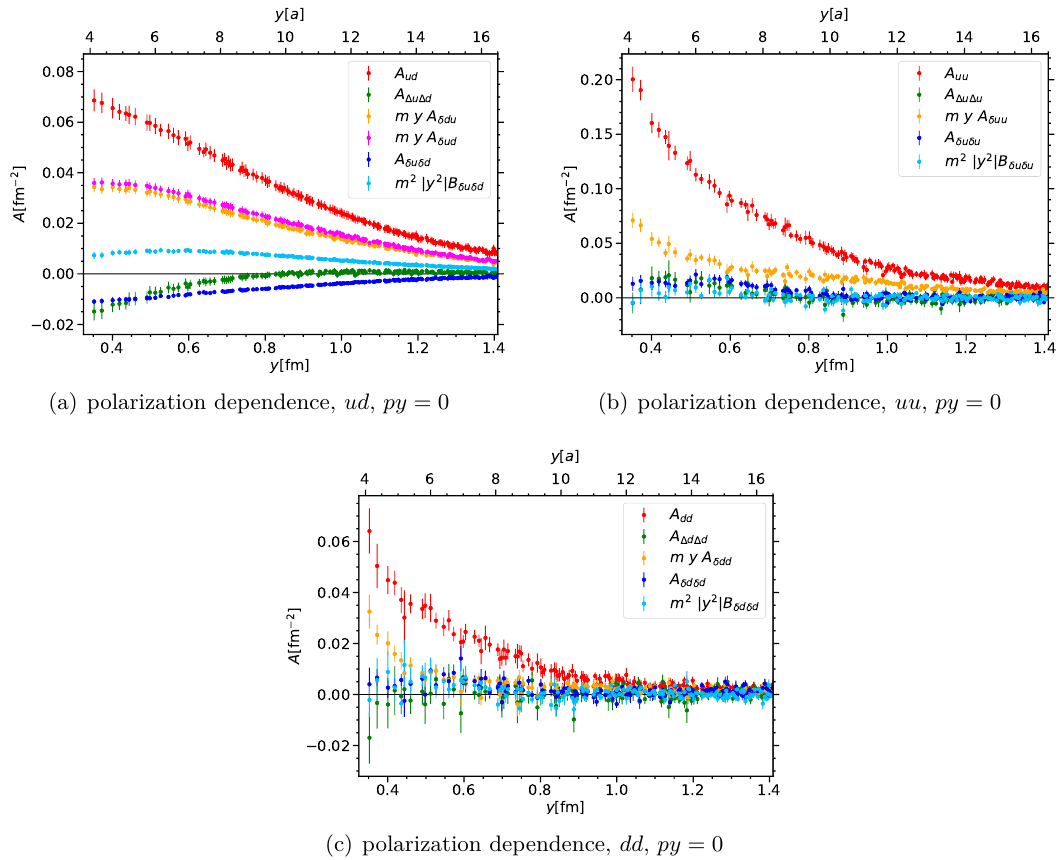
these are uu , ud , and dd , whereas for qq 0 and C are included. 1 2